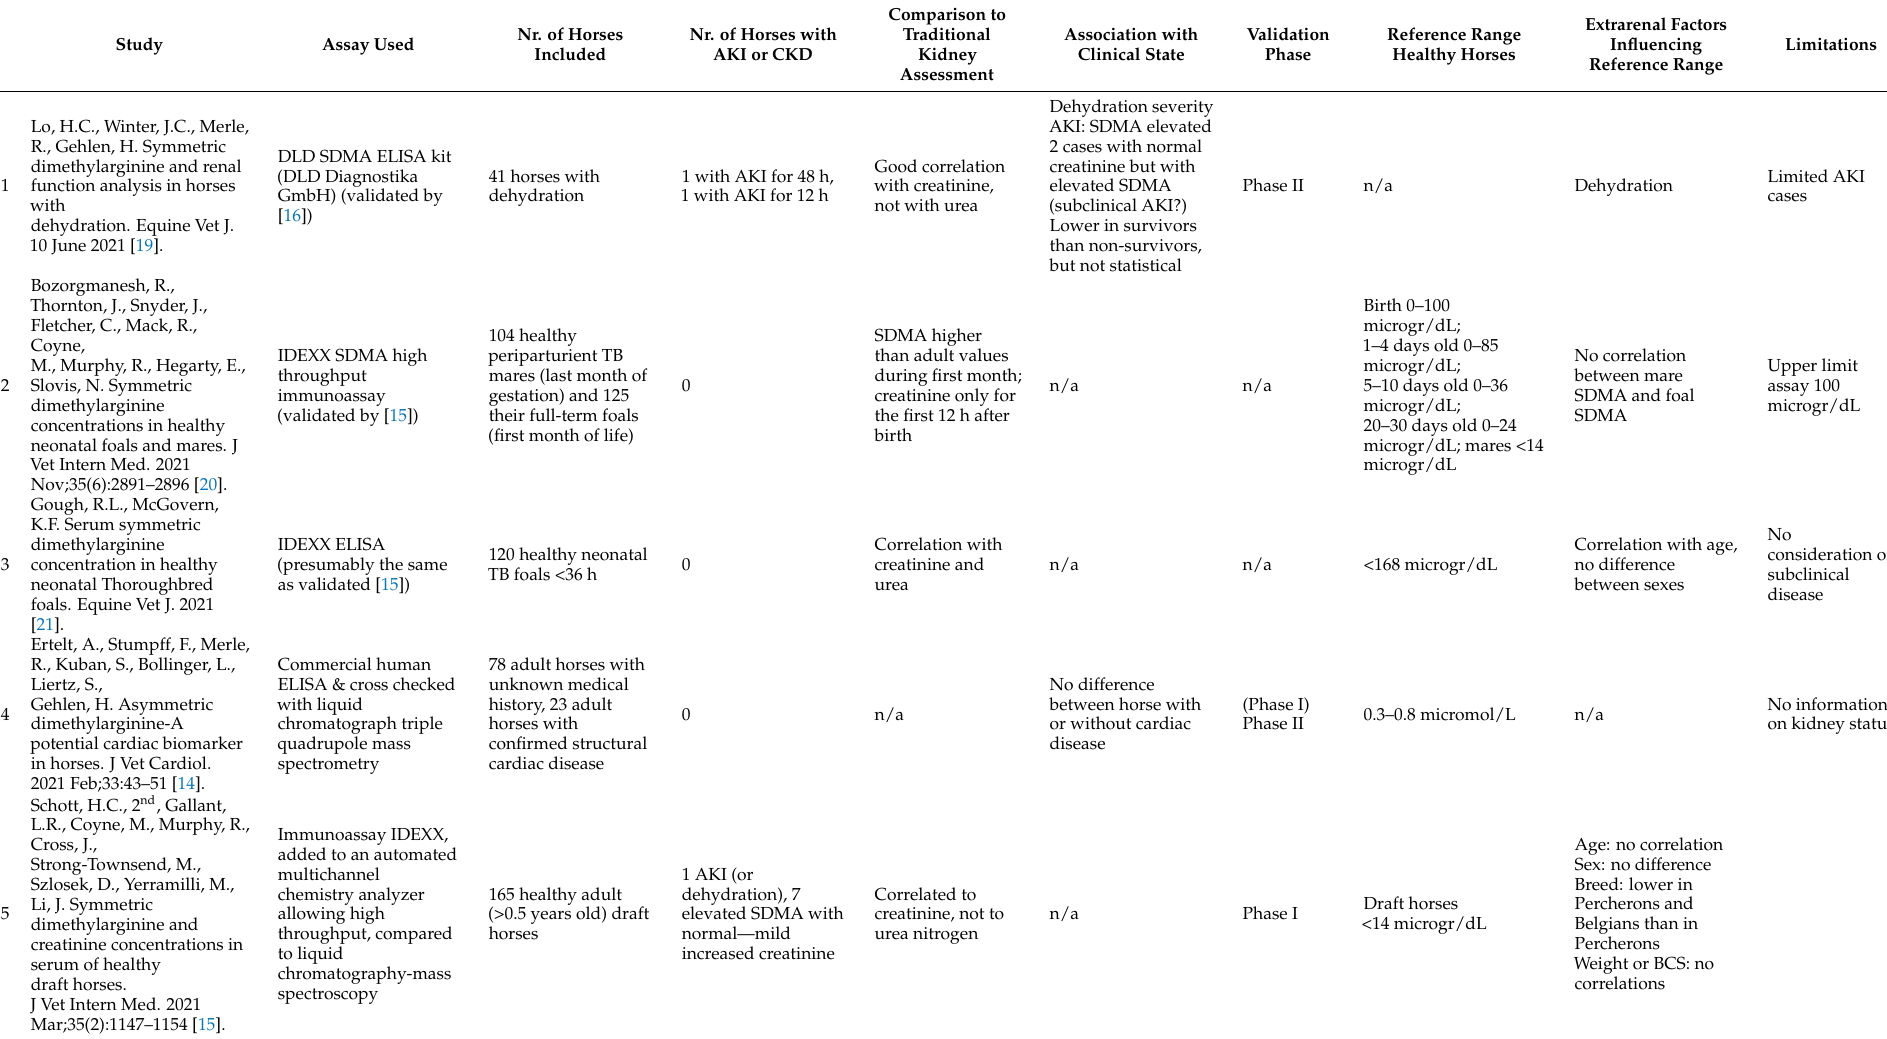
Table 2. List of studies on symmetric dimethylarginine (SDMA) concentrations in blood in horses and its analytical and clinical